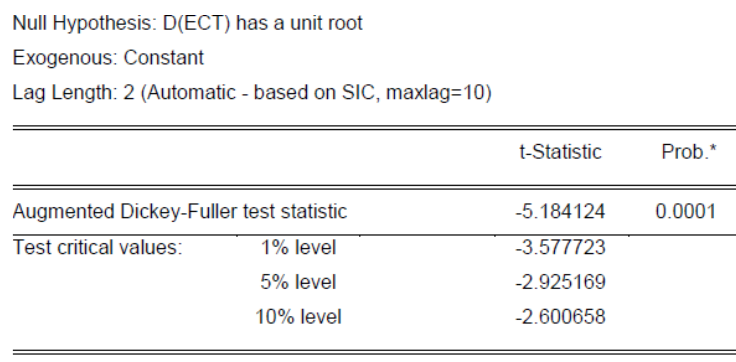
Table 2: Grenger Cointegration Test at First Difference Level